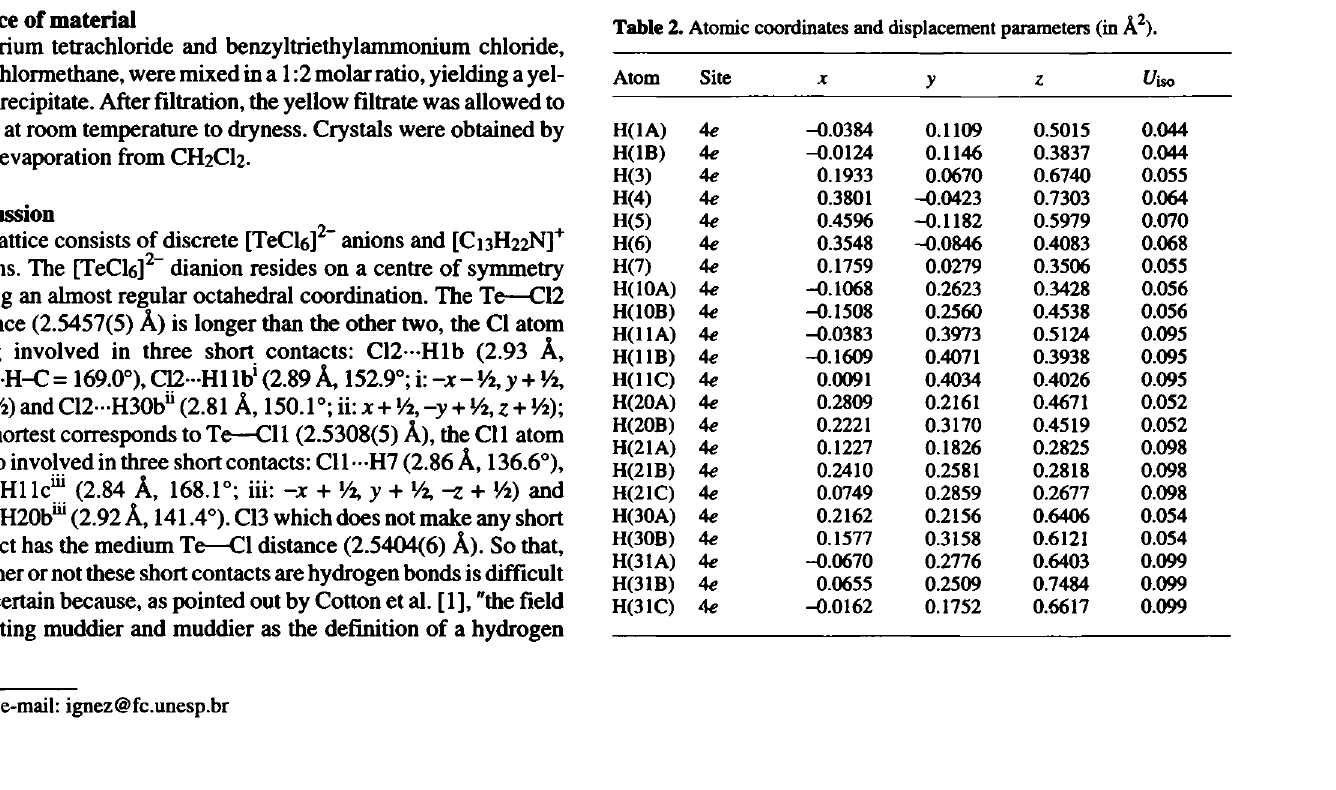
Table 2. Atomic coordinates and displacement parameters (in Â 2